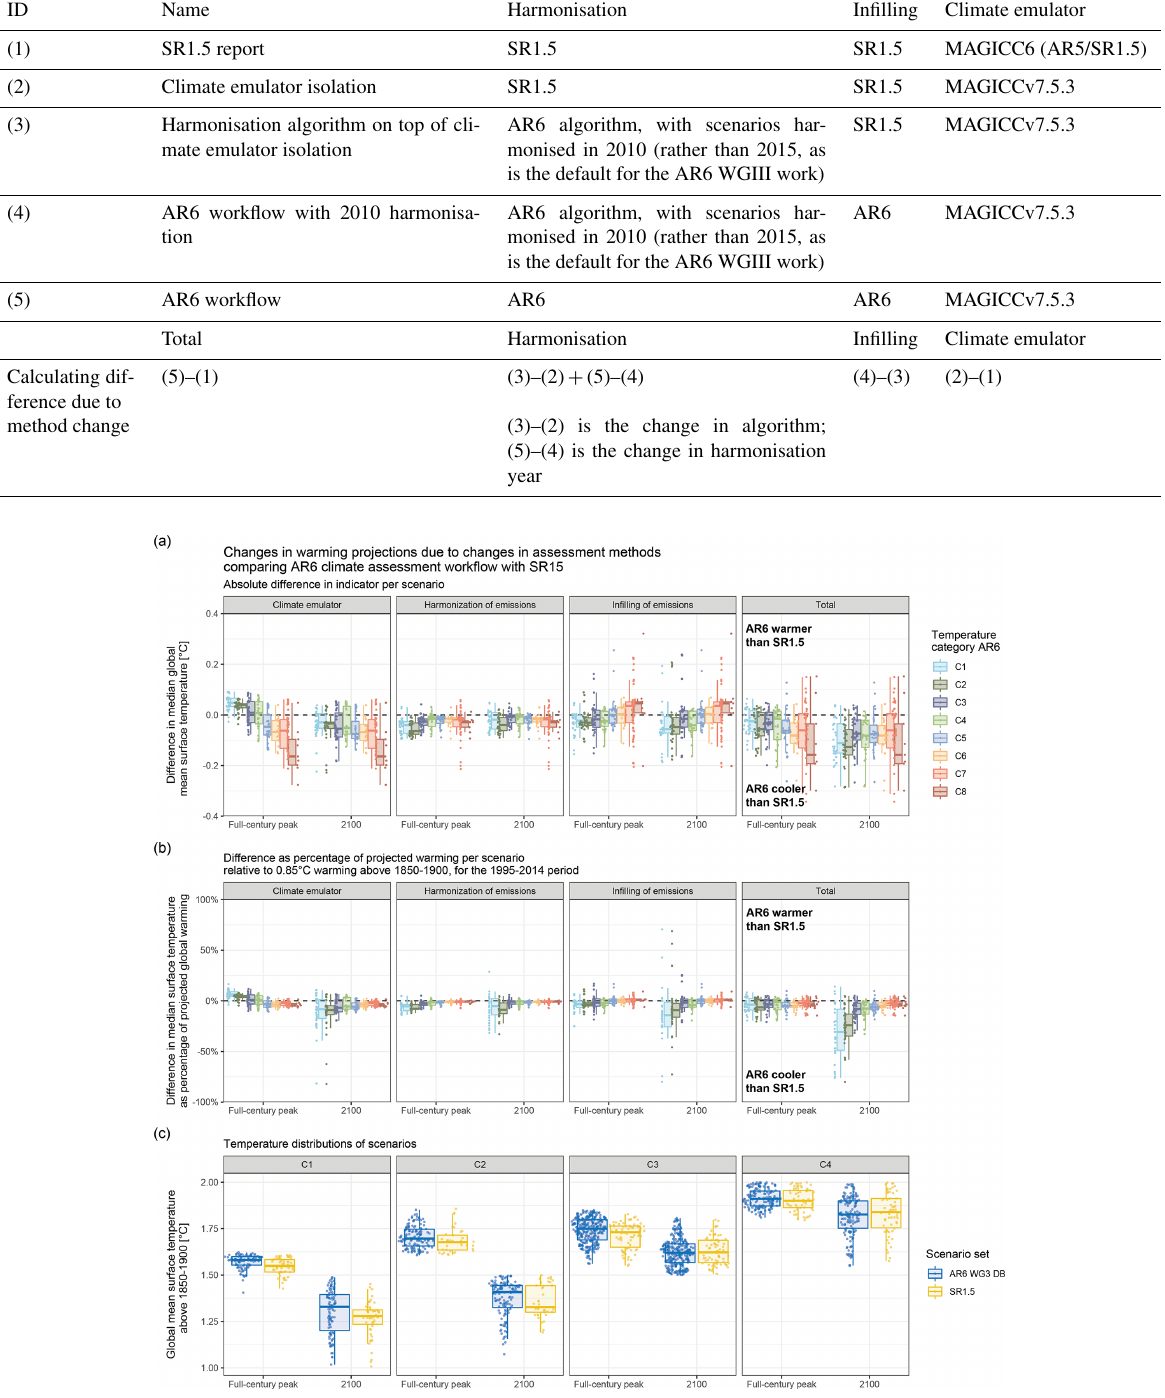
Figure 9. Differences in the AR6 and SR15 climate-assessment workflow steps ( a and b ) and the temperature outcome distributions ( c ) using MAGICC. In panels (a) and (b) , the AR6 temperature categories for a specific scenario were used. In panel (c) , we use the categories as reported in the separate IPCC reports. SR1.5 categories “1.5C low overshoot” and “Below 1.5C” have been mapped as C1, “1.5C high overshoot” as C2, “Lower 2C” as C3, and “Higher 2C” as